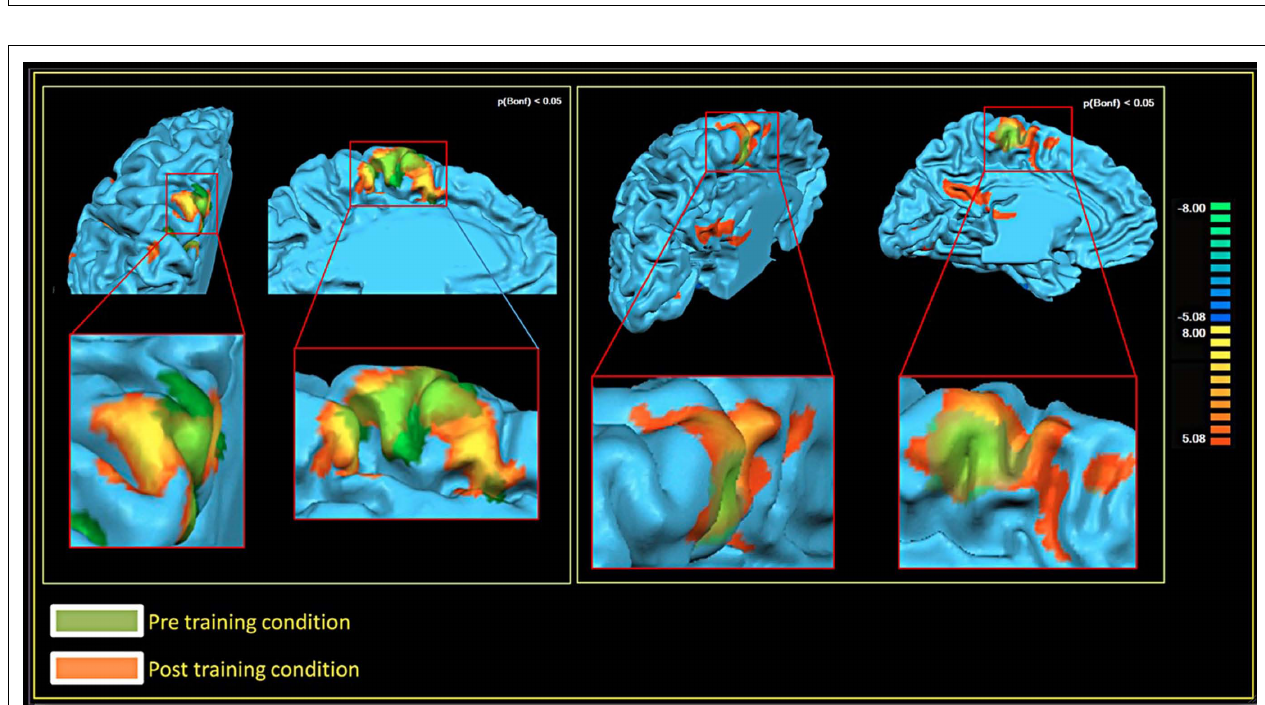
FIGURE 4 | Brain activations in the pre- and post-training conditions, 3D cortex reconstruction of the left hemisphere. Patient M.E. on the left. Patient S.R. on the right.